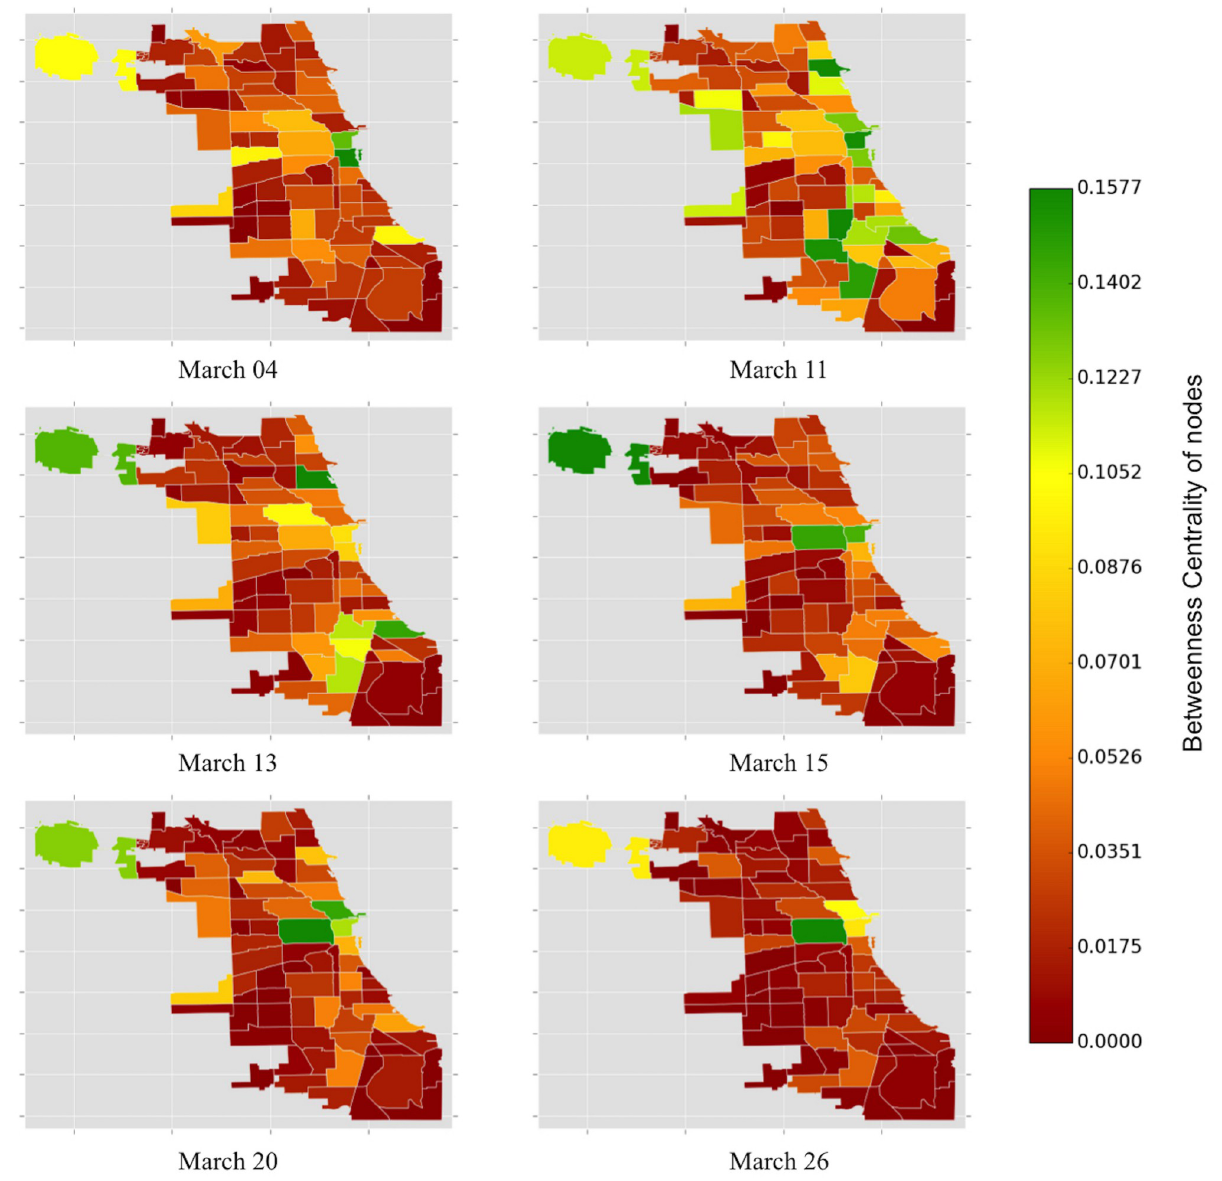
Fig 8. The color of the Chicago community areas is proportional to the weighted betweenness centrality of the nodes (community areas). Zones with a higher number of COVID-19 cases and deaths appear to have relatively lower values of weighted betweenness centrality. On March 13, 2020, we observe a surge in the weighted betweenness centrality for Lake View, O’Hare, South Shore, Greater Grand Crossing, Chatham, and Roseland. During the weekend (March 15), O’Hare experiences a further surge in weighted betweenness centrality. Again, on March 20 and 26, 2020 we note that O’Hare, Loop, and Near West Side have high values of weighted betweenness